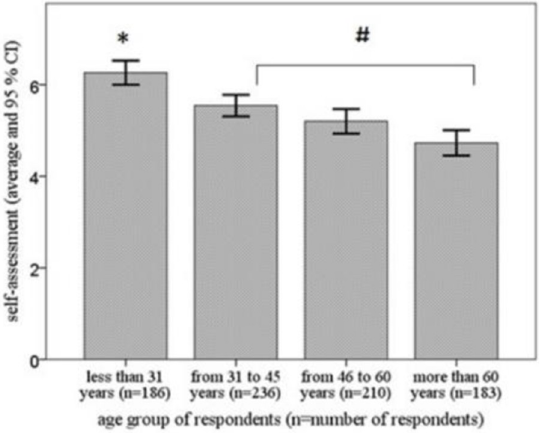
Fig 1. Self-assessment of the knowledge of first aid assessed by the 11-point Likert scale (from 0 -lowest grade to 10—highest grade). Legend: Average grades for different age categories of the respondents are expressed as means ± CI (confidence interval). n–number of respondents per in age group; � —statistically significantly (p < 0.05) different when compared with all other groups; #—statistically significantly (p < 0.05) different from the oldest age